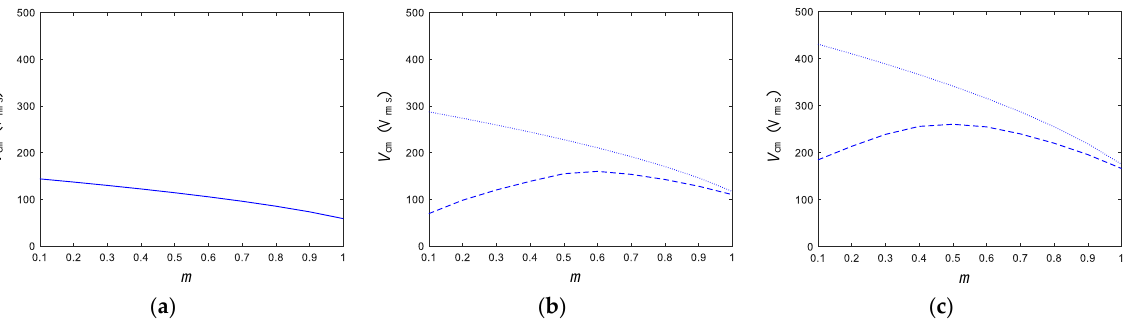
Figure 13. Root-mean-square value of the common-mode voltage as a function of the modulation index. Dotted lines correspond to design A, dashed lines correspond to design B, and solid lines correspond to both design A and design B. ( a ) EV 1 . ( b ) EV 2 . ( c ) EV 3 . Table 5. Inverter leg MTTF